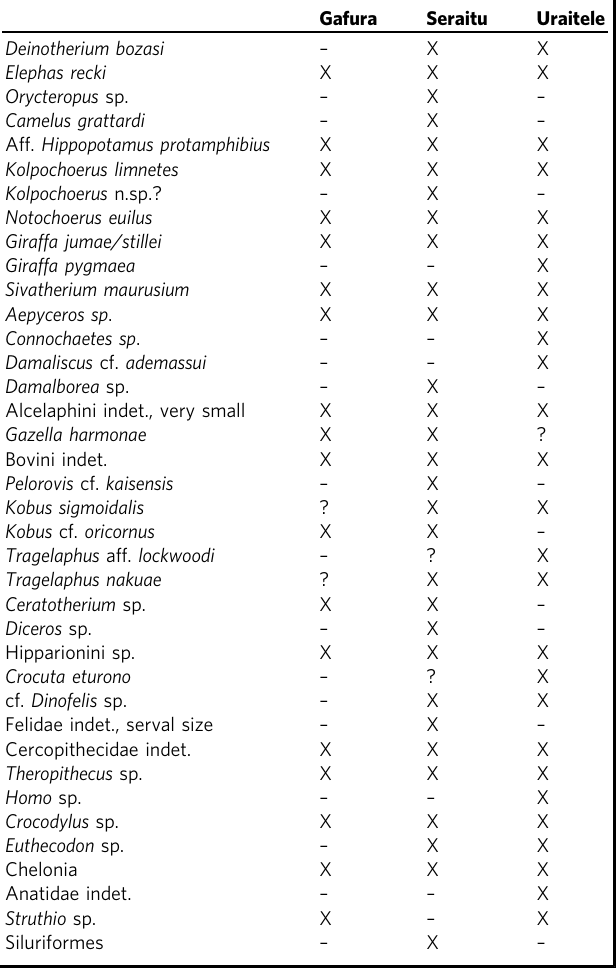
Table 1 Distribution of vertebrate taxa across the MLP main groups of